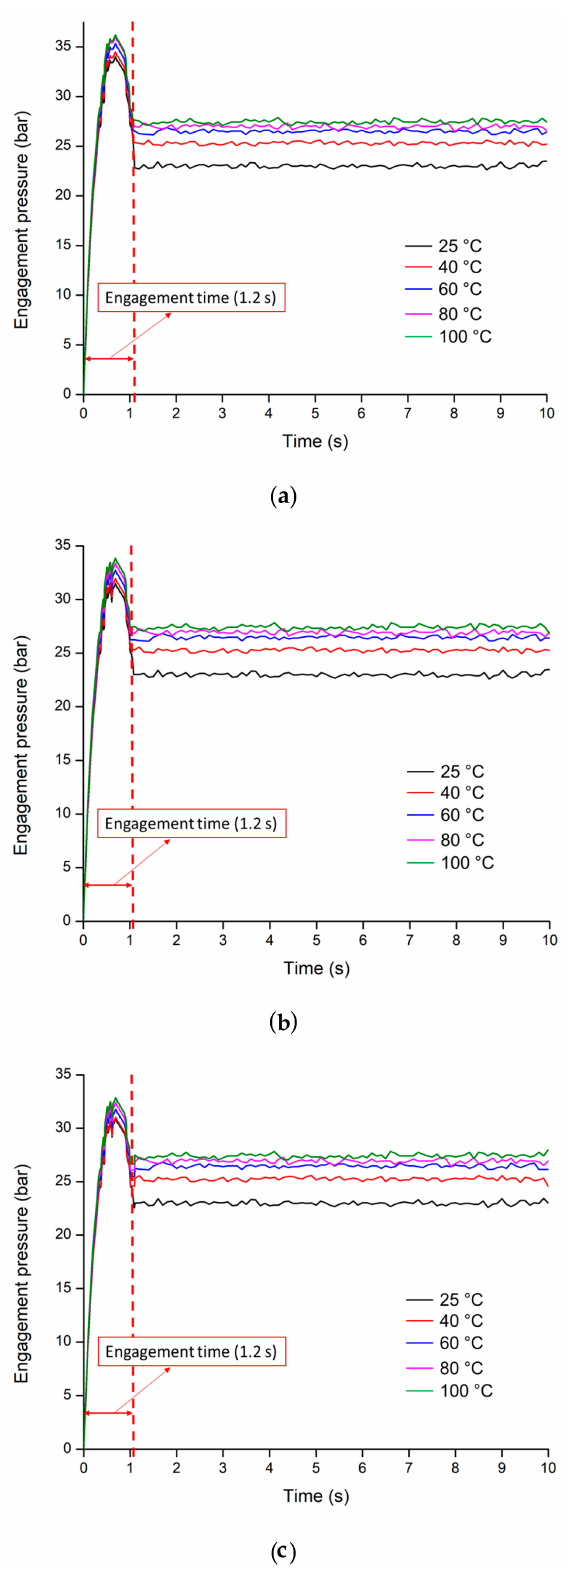
Figure 14. The engagement pressures of the clutch at di ff erent temperatures of the hydraulic oils: ( a ) VG 32; ( b ) VG 46; ( c ) VG